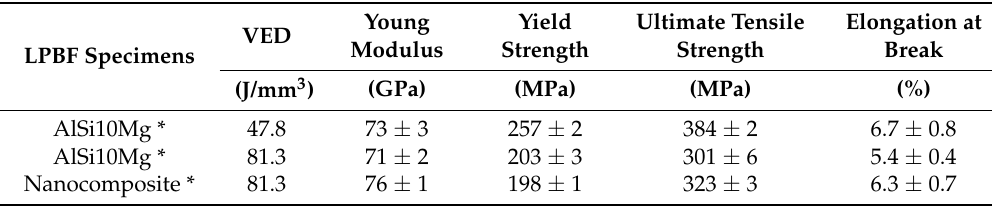
Figure 5. ( a ) Tensile stress ‐ strain curves of nanocomposite samples built using the selected VED (81.3 J/mm 3 ); AlSi10Mg built using the chosen VED of nanocomposite (81.3 J/mm 3 ) and with standard VED (47.8 J/mm 3 ). All the samples were built along the x ‐ direction; ( b – d ) FESEM images of the samples revealing their cellular structure sizes along the building direction; ( e ) Schematic melt pools representation along the building direction, indicating the position of the taken FESEM images. Table 5. Tensile properties obtained for AlSi10Mg built using different VED values and nanocomposite samples built with the selected VED value along the x ‐ direction.